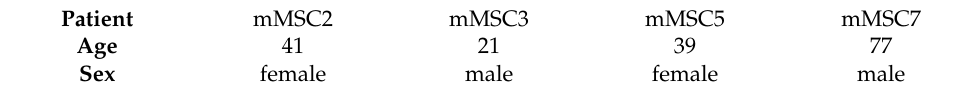
Table 1. Age and sex of the